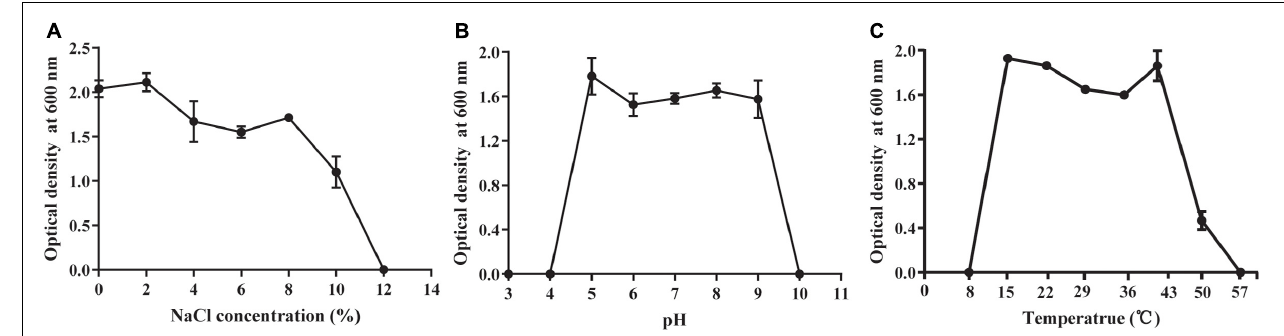
FIGURE 4 | Growth of B. megaterium HGS7 under different cultural conditions. (A) Different concentrations of NaCl. (B) Different pH values. (C) Different temperatures. Data represent mean ± standard deviation ( n = 3).